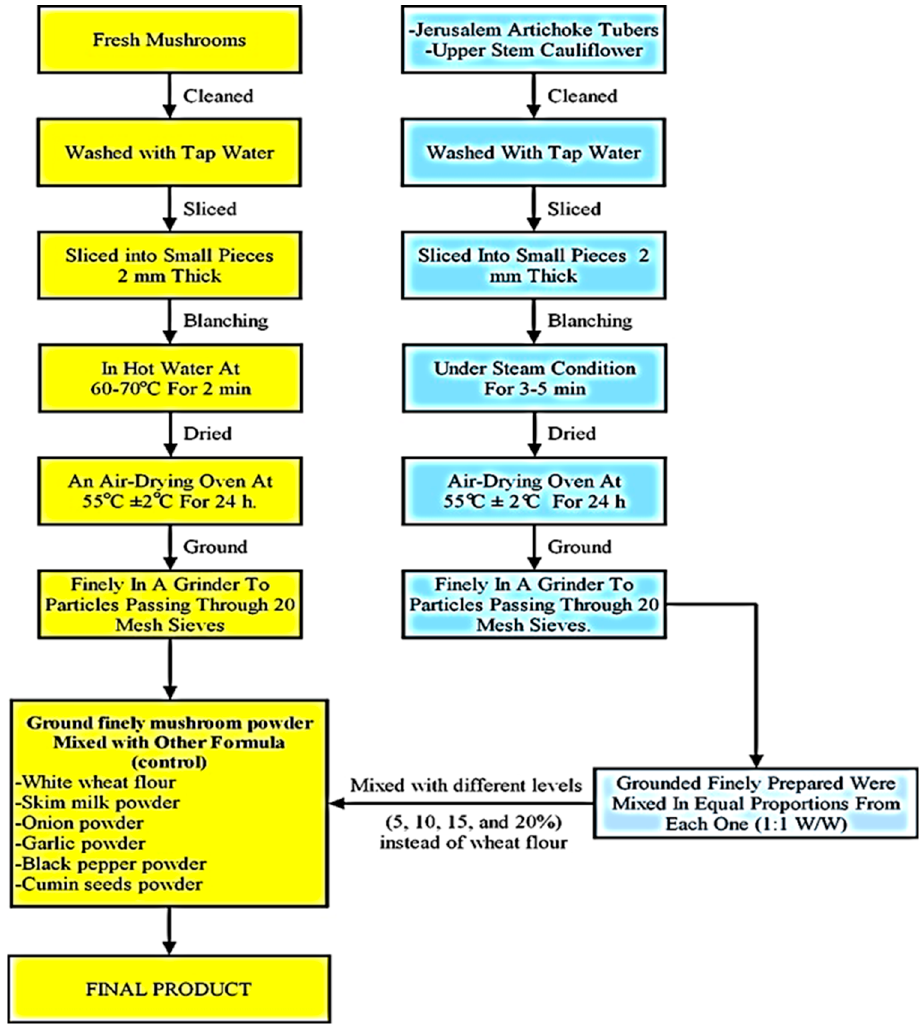
Figure 1. Flow diagram for the production of dried instant mushroom-JACF soup.